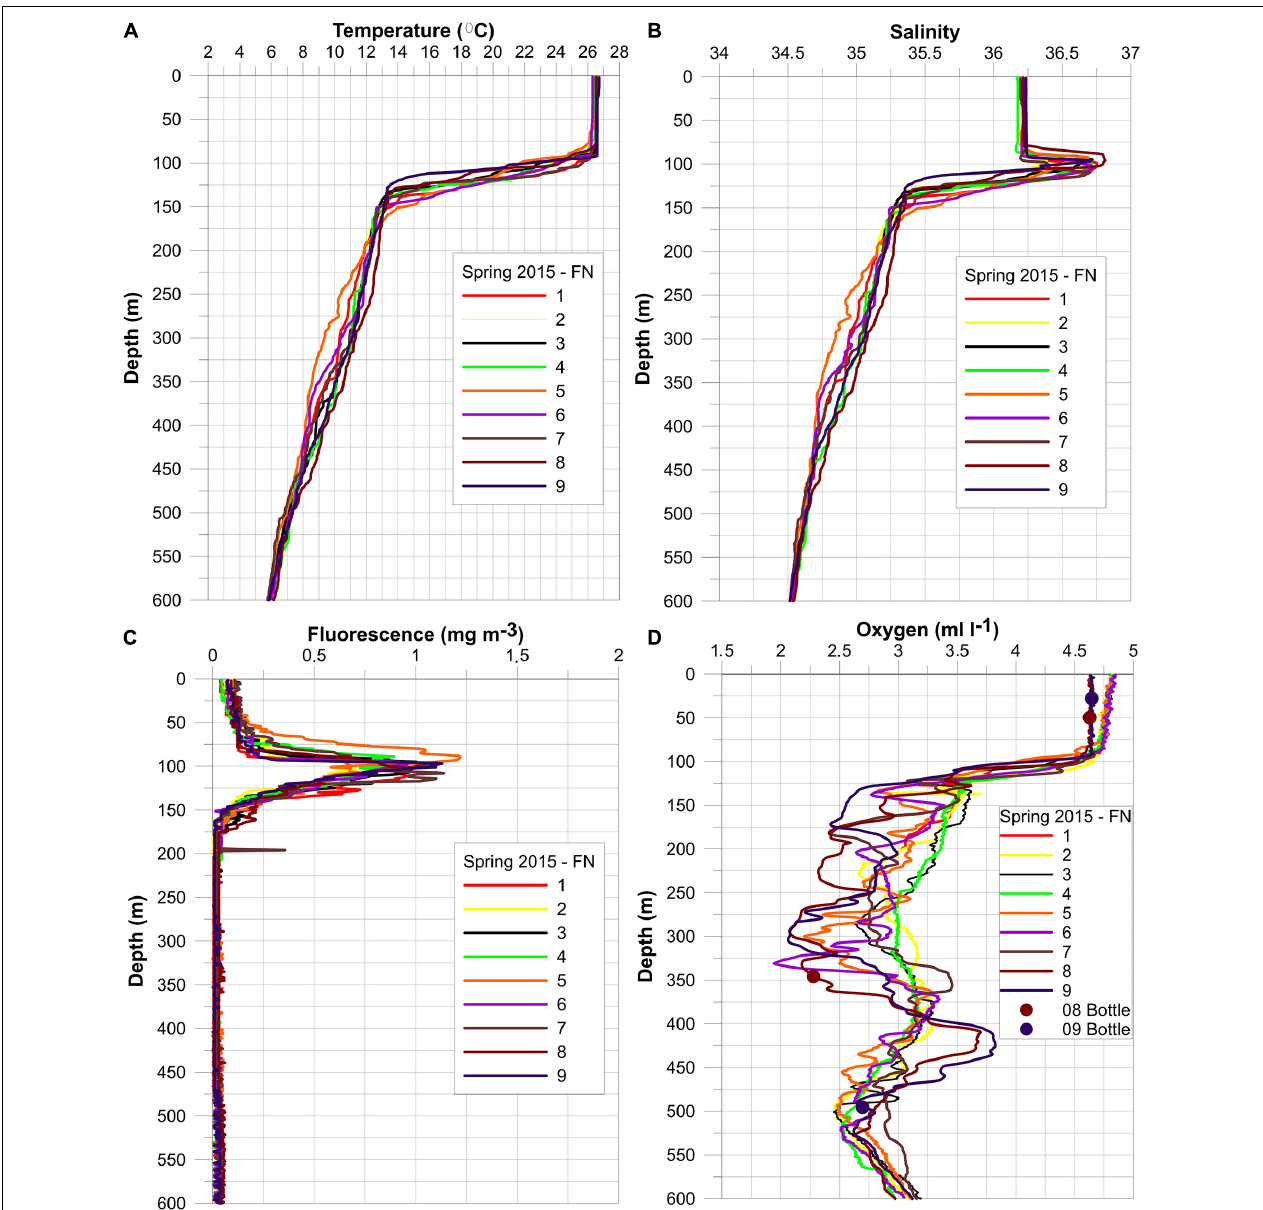
FIGURE 4 | CTD profiles obtained during the ABRACOS surveys in spring 2015 around the Fernando de Noronha Archipelago. Vertical profiles of temperature (A) , salinity (B) , fluorescence (C) , and dissolved oxygen (D)